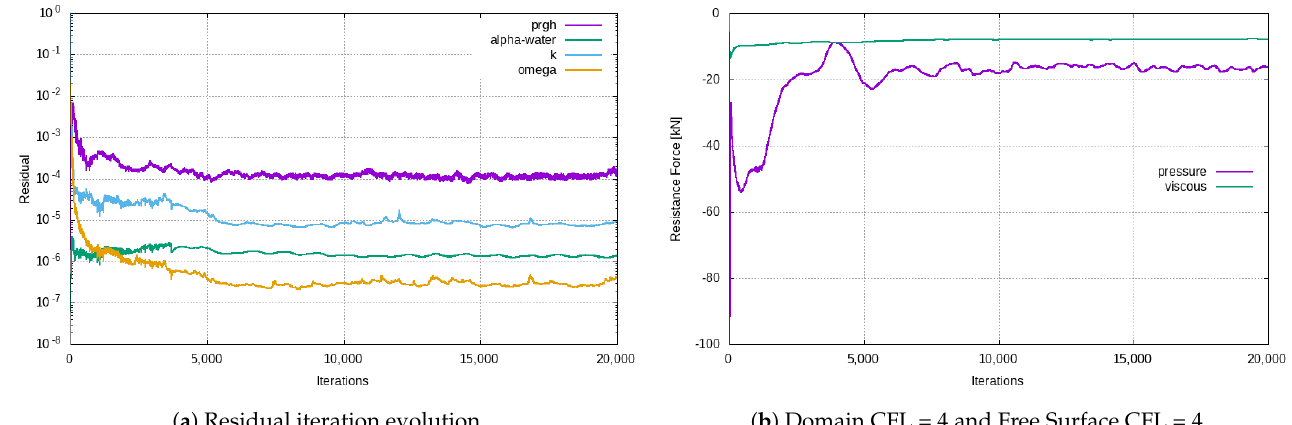
Figure 11. Residual and force evolution of viscous and pressure components acting on the Type 209/1300 submarine navigating at H / D = 0.33 and Fr = 0.194 using the fine grid.